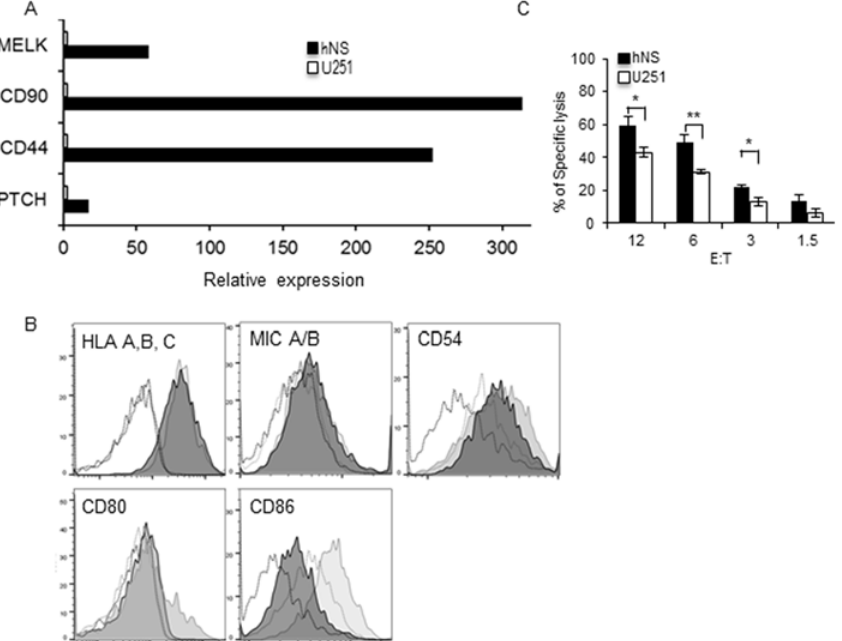
Fig 1. Human Glioma stemlike cells are better killed by YT-Indy NK cells. (A) Messenger RNA expression of the stem cell markers MELK, CD90, CD44 and PTCH, for U251 differentiated glioma cells and hNS cells assessed by qRT-PCR. (B) Phenotyping of U251 and hNS cells for the surface expression of MHC class I, MICA/B, CD54, CD80, CD86. Filled dark and light grey histograms are for hNS and U251 respectively, open dark and light grey histograms are the corresponding controls. (C) U251 and hNS were also used as target YT-Indy in a 4 hour calcein AM release assay. All data are representative of 3 independent experiments. Bar graphs represent mean +/- SD of three independent experiments. P value * p (cid:3) 0.05, ** p (cid:3) 0.01, one-sided t-test.